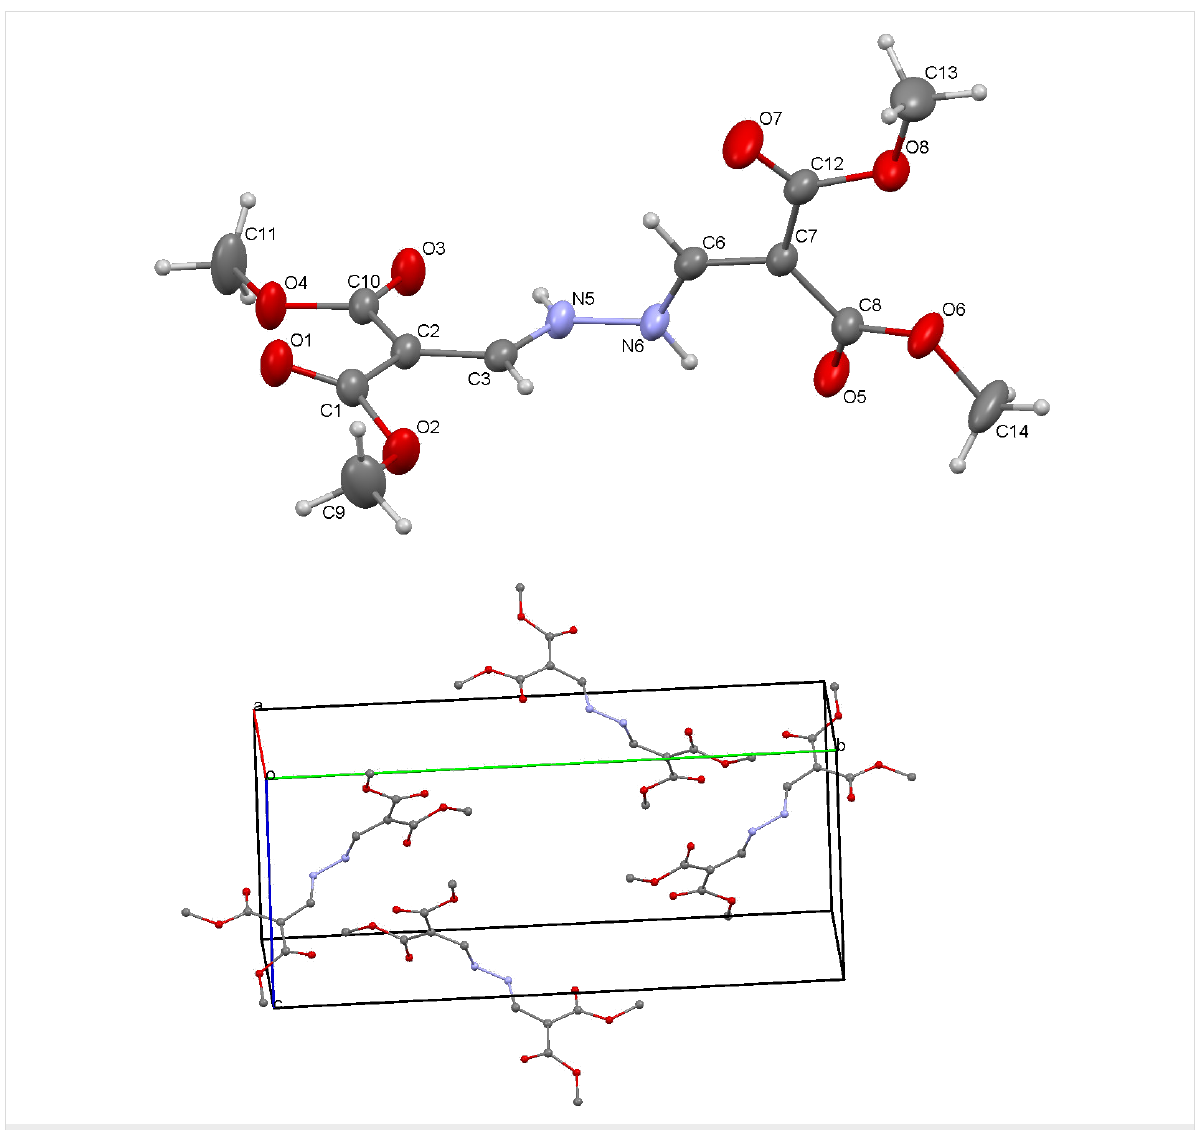
Figure 5: Crystal structure and crystal packing of compound 6a .